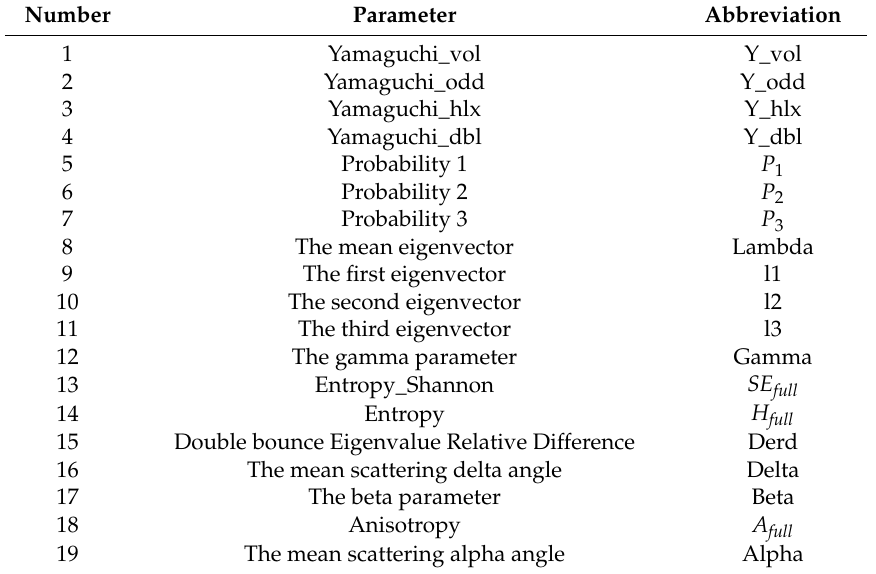
Table 3. Overview of the 25 parameters derived from the full-polarimetric RADARSAT-2